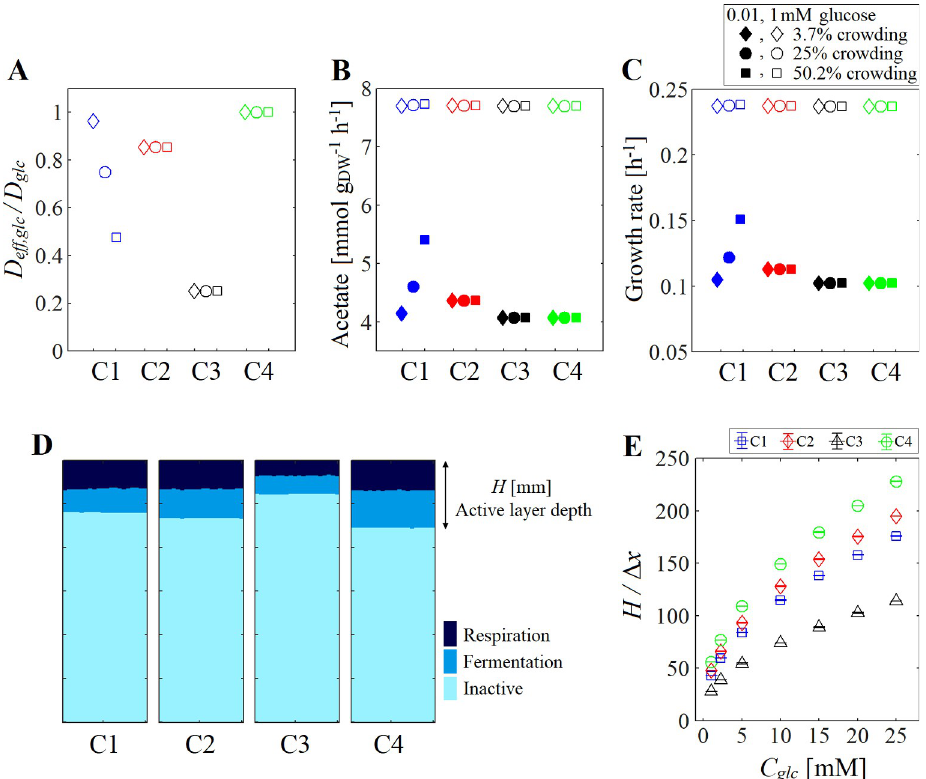
Fig 2. Diffusion and metabolic activity under different crowding assumptions. (A) Relative diffusion of glucose, (B) acetate flux and (C) growth rate predicted for a single cell in a box of 6.86 x 10 − 9 mm. Three crowding conditions were tested: 3.7% (using R cell = 4 x 10 − 4 mm, diamond), 25% ( R cell = 7.4 x 10 − 4 mm, circle) and 50.2% ( R cell = 9.5 x 10 − 4 mm, ) were supplied: 0.01 mM (closed symbols) and 1mM (open square), and two different glucose concentration ( C glc symbols). The relative diffusion was not affected by C glc , therefore open and closed symbols overlap in (A). (D) Phenotype distribution predicted after 0.1 h for a small biofilm system under assumption C1-4 (Table 2). A squared lattice ( Δ x = 1.3 x 10 − 3 mm) was used to simulate a system of 0.57 mm by 0.0380 mm filled with 6 000 E . coli cells, where glucose 2.25 mM was supplied from the top boundary. The simulation parameters are in Table 1. (E) Active layer depth H (normalized by Δ x ) estimated in C1-4 for different C glc supplied to